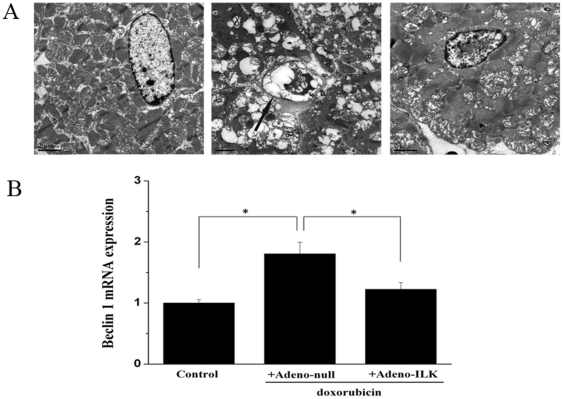
Cardiac ILK gene therapy inhibits doxorubicin-induced autophagy.A, Electron micrographs showing autophagic vacuole (arrow) formation in cardiomyocyte of a doxorubicin-treated rat administered adeno-null, and lack of this in another rat administered adeno-ILK and in a control (saline-treated) rat. Scale bar, 2 µm. B, Effect of doxorubicin treatment on cardiac beclin 1 mRNA expression, and the effect of ILK treatment on this. Beclin 1 mRNA expression levels were normalized first to GAPDH and then displayed relative to levels in the control group using the2−ΔΔCt method. n = 6 per group. *P<0.05.